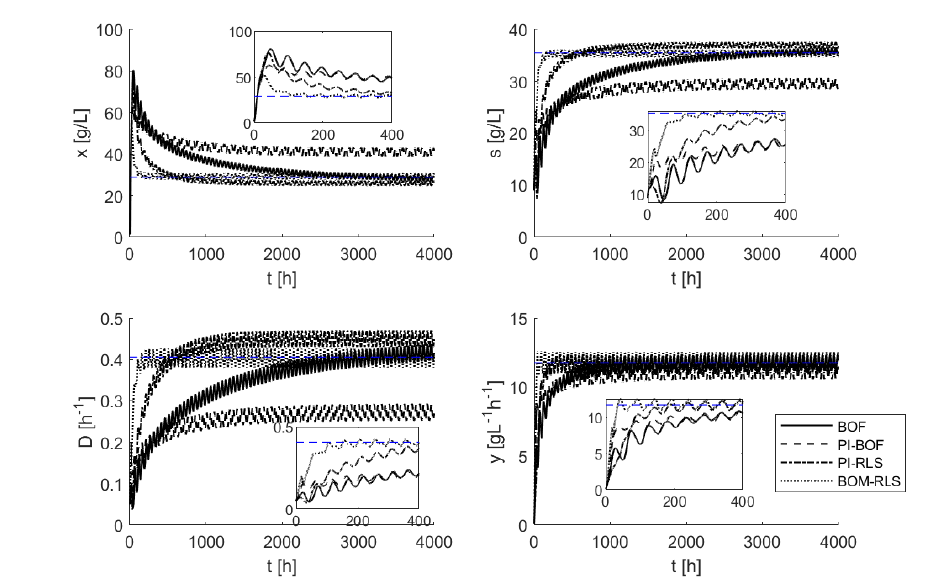
Figure 12. Application of the BOF, PI-BOF, PI-RLS, and BOM extremum seeking methods to optimize biomass productivity of microbial growth represented by model (3) with Contois kinetics—state, input, and output time